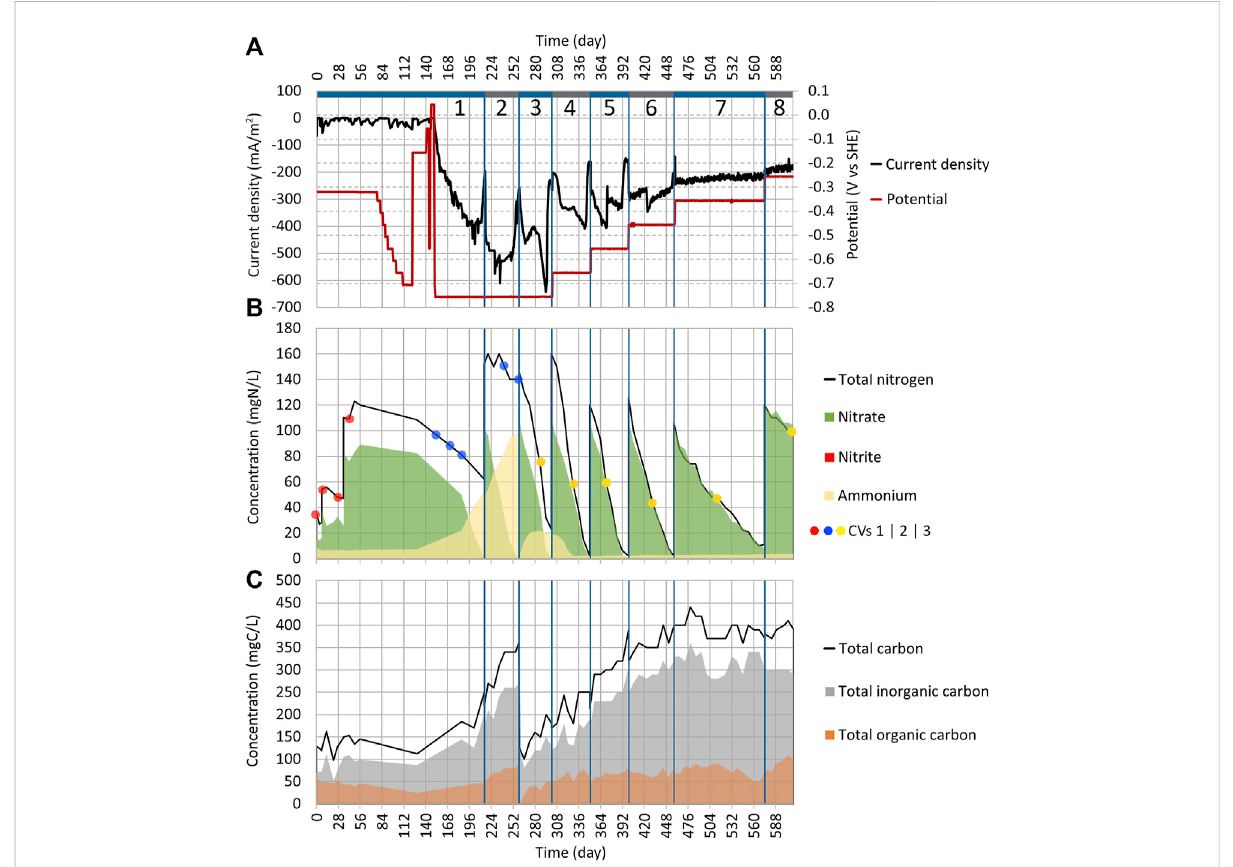
Dynamics of key parameters in Reactor 1 during cycles (1:1) to (1:8). (A) Change of current density and working electrode potential in time. (B) Area graph of total nitrogen, nitrate, nitrite, and ammonium concentrations in the electrolyte; the red, blue, and yellow dots represent when the CV measurements (shown in Figures 4, 9) were performed. (C) Area graph of total carbon, total inorganic carbon, and TOC concentrations in the electrolyte. The blue vertical lines represent borders between the